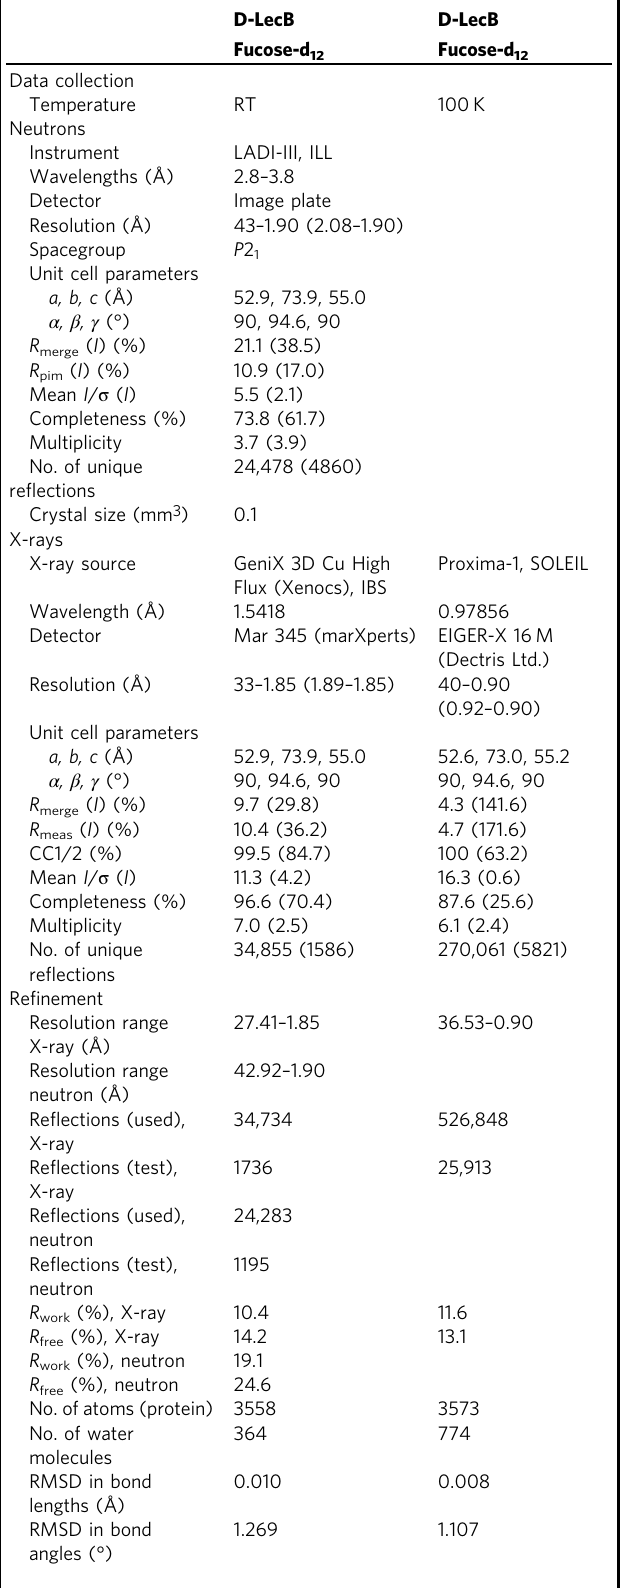
Table 1 Room temperature neutron data collection, 100 K X-ray data collection and re fi nement statistics for the perdeuterated LecB/fucose